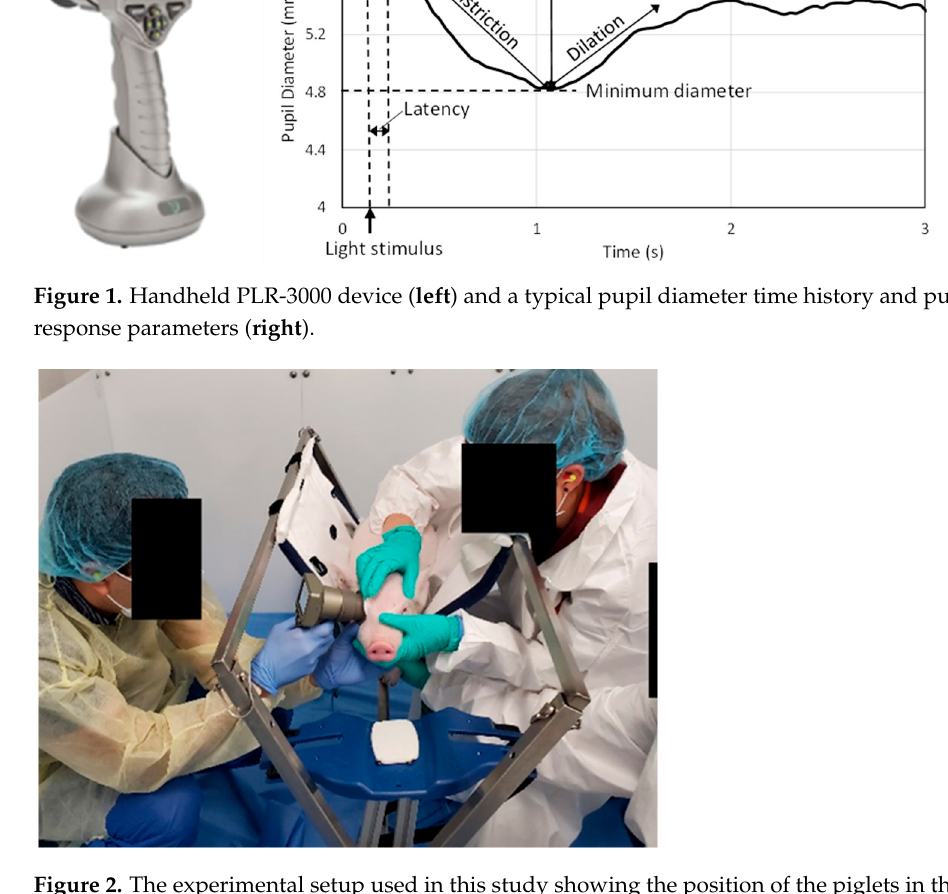
Figure 1. Handheld PLR-3000 device ( left ) and a typical pupil diameter time history and pupillary response parameters ( right ).